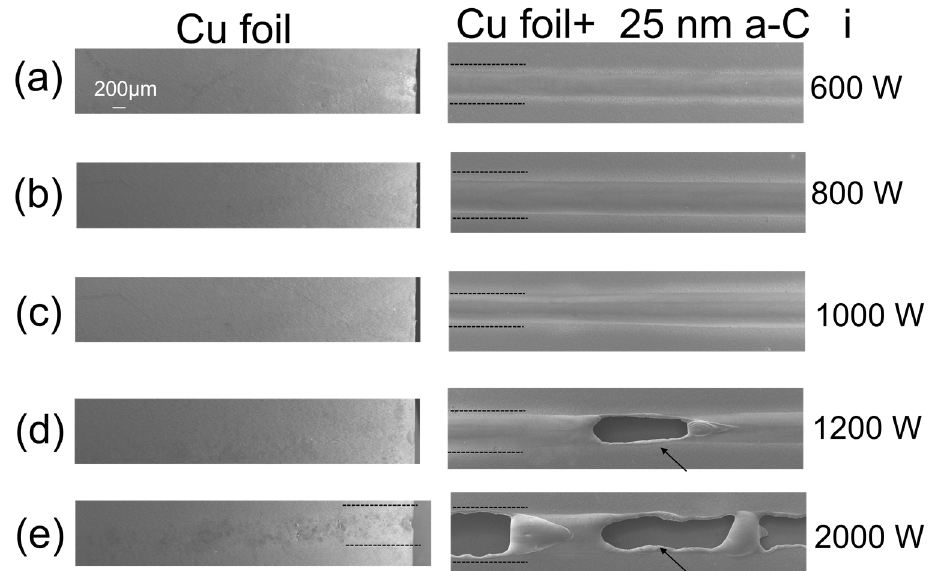
Figure 4. Topography SEM images of Cu foil ( FCu-i/ right ) and covered with a-C films (a-C25/ left ) using the laser power of ( a ) 600 W; ( b ) 800 W ( c ) 1000 W ( d ) 1200 W and ( e ) 2000 W..